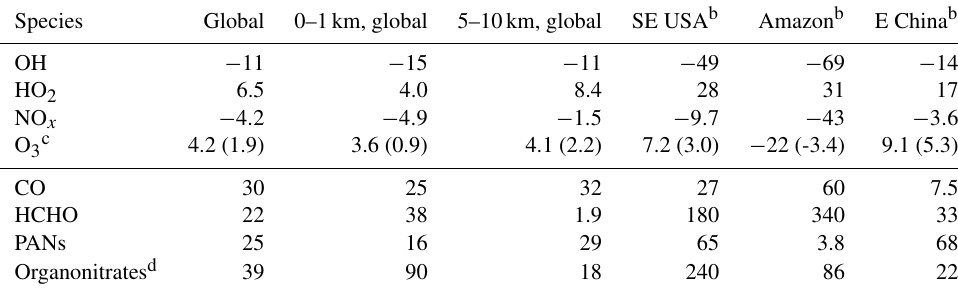
Numbers in parentheses are annual mean absolute changes in parts per billion volume. d Not including